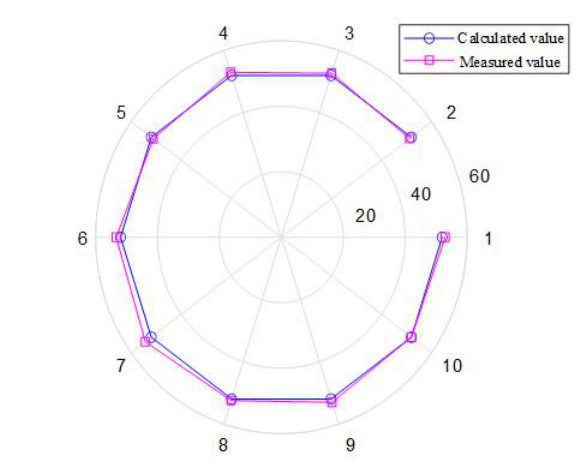
Fig. 16. Comparison between calculated and measured temperature rise of plum blossom contact tact can reach 160.27°C, which has an adverse effect on the elastic deformation of the finger end. 3. Based on the random forest regression model, the max- imum temperature of plum blossom contact under fault current can be accurately